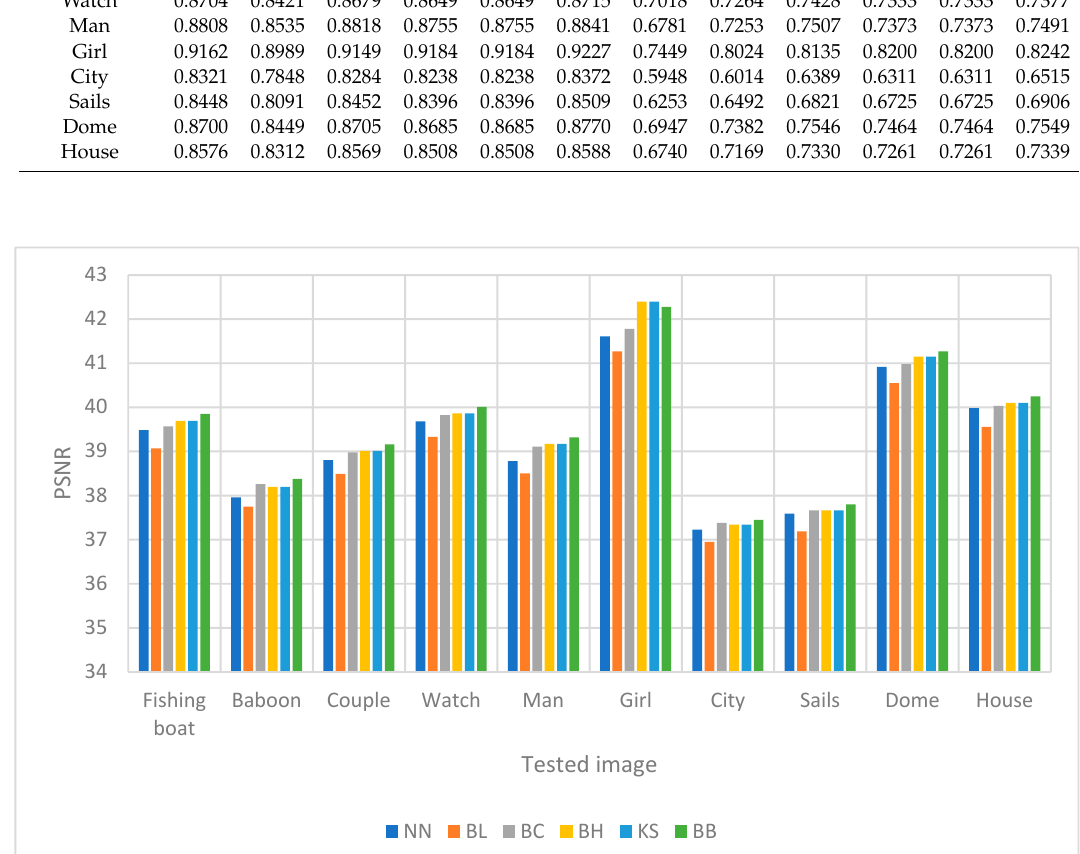
Figure 7. A comparison of schemes in regard to PSNR for image upscaling with a factor of two.